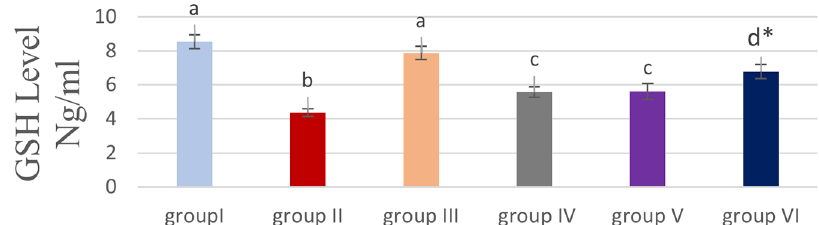
Figure 1. Showing the effect of cyanocobalamin on glutathione (GSH) contents in the kidney tissue homog- enate of rats. - Each value represents mean (cid:3) standard error of means (SEM) (N=7/Group), - Values expressed in non-identical letters (a, b,c ,d) are significantly difference (P<0.05), - *Highly significant difference from MTX